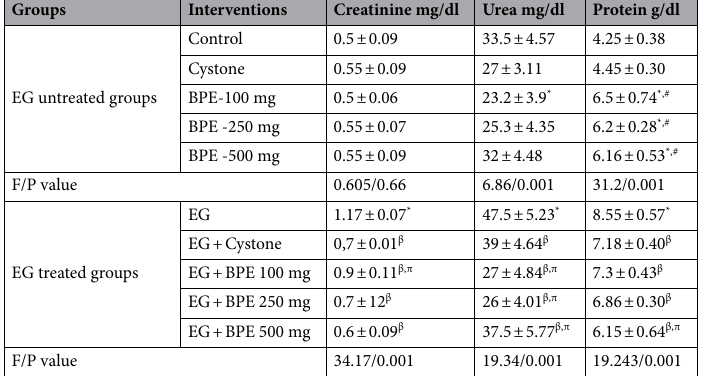
Table 1. Effect of the interventions on blood level of urea, creatinine and protein on day 30. * P < 0.05 compared to EG untreated-control group. # P < 0.05 compared to EG untreated-cystone group. β P < 0.05 compared to EG treated group. π P < 0.05 compared to EG treated-EG + cystone